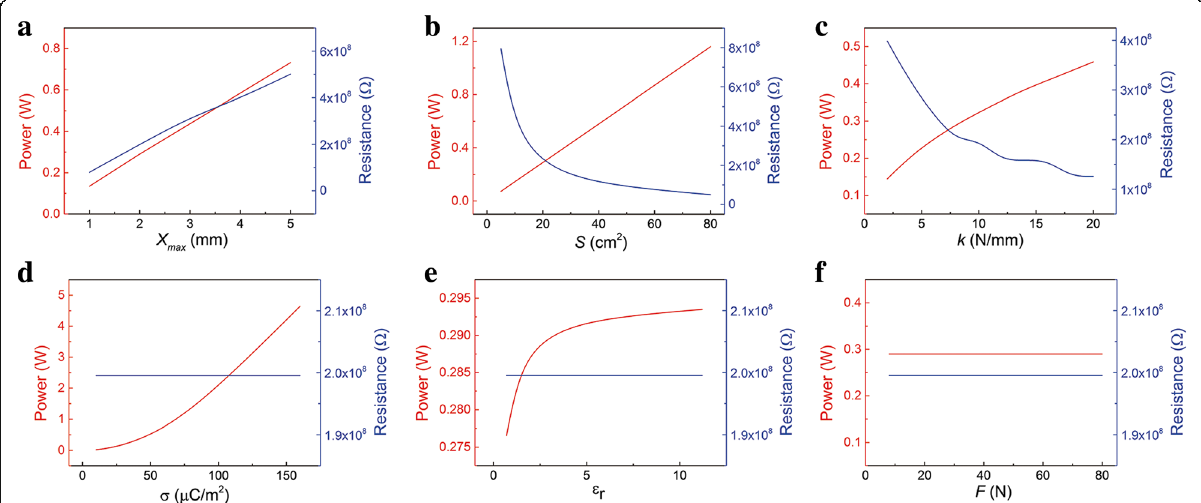
Fig. 5 Influence of the parameters on the P max and corresponding resistance in one cycle. The relationship of P max and corresponding resistance with the parameters a x max , b S , c k , d σ , e ε r , and f